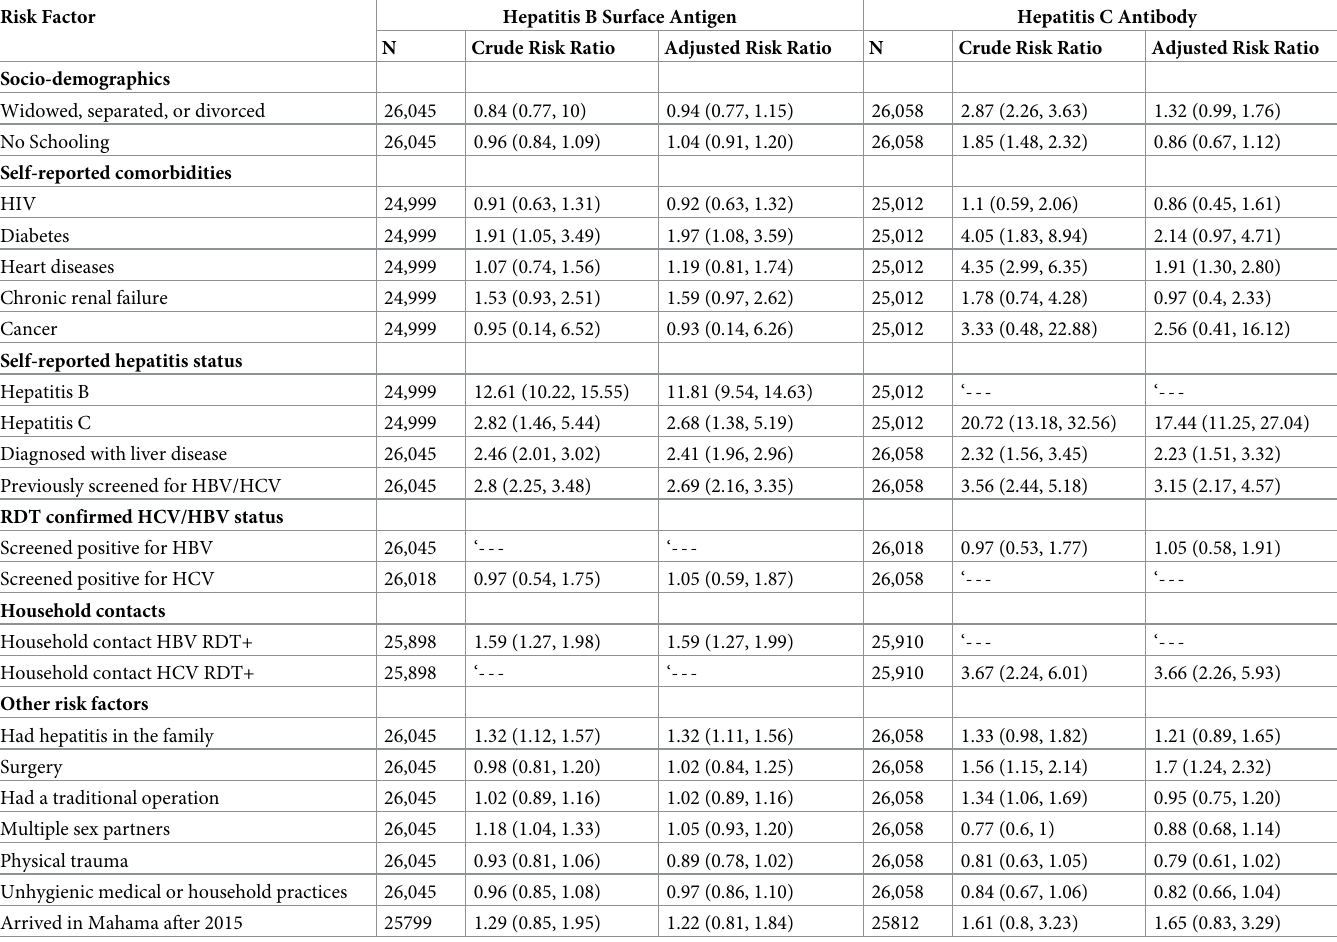
Table 2. Risk ratios for the association between risk factors and hepatitis B surface antigen or hepatitis C antibody.